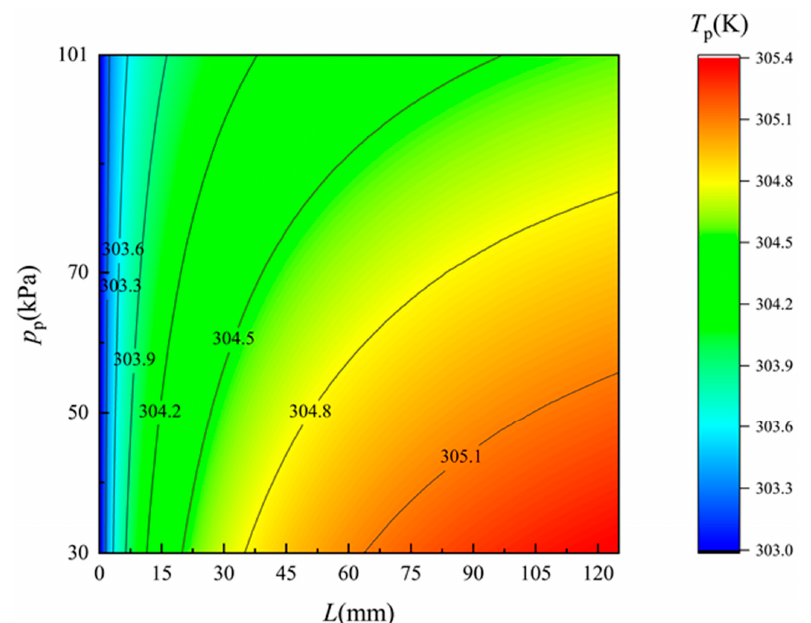
Figure 7. Temperature distribution of the flow along the permeate side of the membrane surface. T f = 318 K.